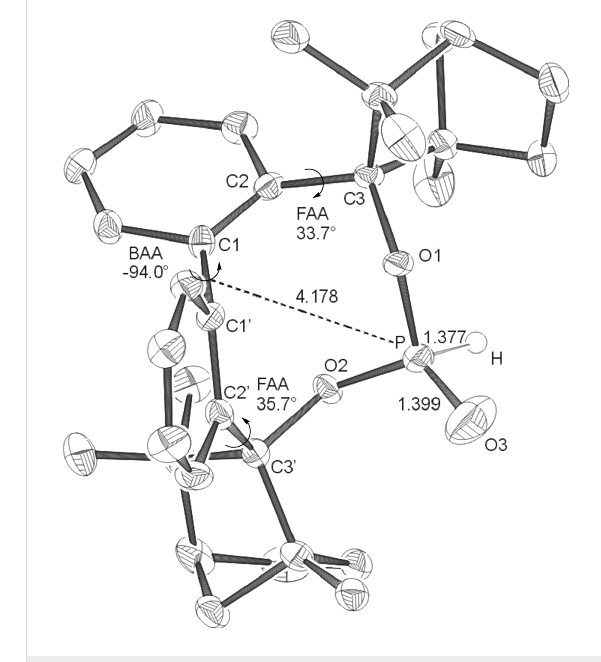
Figure 3: X-ray structures of BIFOP-H ( 3 ). Distances are given in Å. (BAA = biaryl angle between C 2 -C 1 -C 1 '-C 2 '; FAA-lp = fenchyl-aryl dihedral angle between C 1 -C 2 -C 3 -O 1 ; FAA = fenchyl-aryl dihedral angle between C 1 '-C 2 '-C 3 '-O 2 ). The probability of ellipsoids is 40% (CCDC 270533).